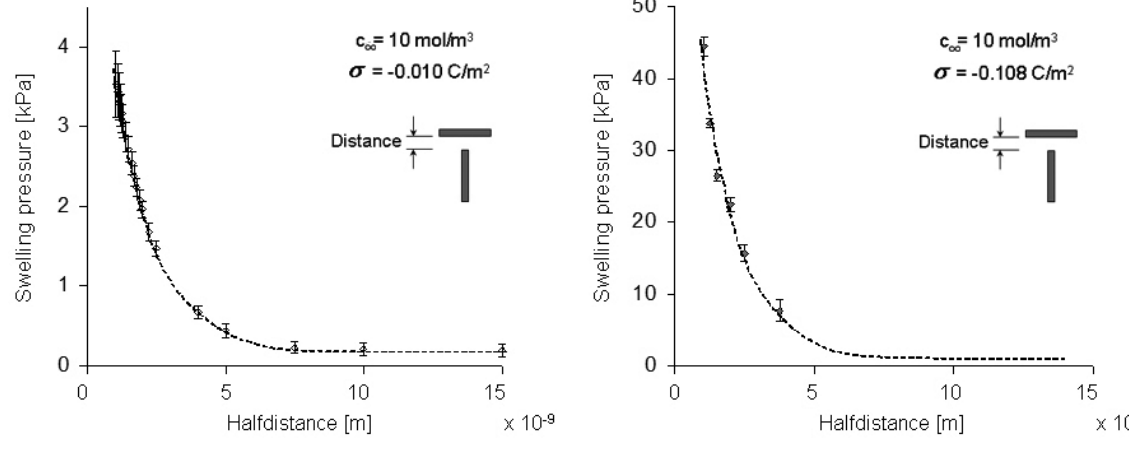
Fig. 7 – Swelling pressure in edge-to-face configurations ( c